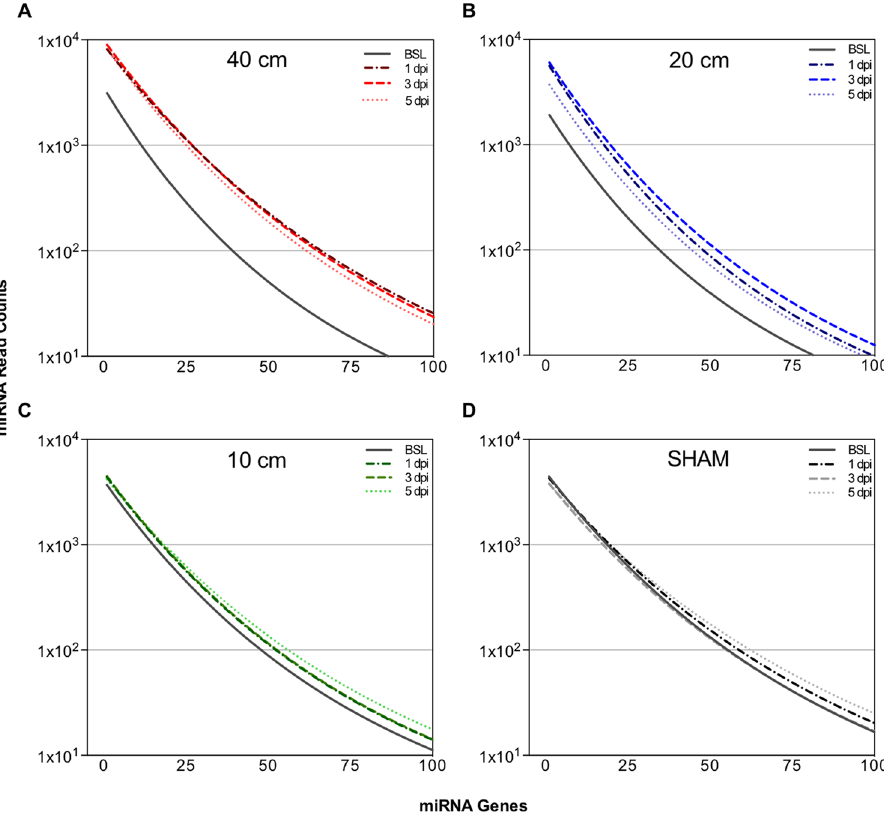
Figure 6. Effect of Injury Severity on Global miRNA Expression. Smoothed lines showing the trend in global miRNA expression at BSL (solid lines), and at 1, 3, and 5 dpi (dashed lines) in each of the ( A ) 40 cm, ( B ) 20 cm, ( C ) 10 cm, and ( D ) SHAM groups. Datapoints represent the smoothed read counts for the top 100 miRNA genes for n = 4 animals per group and time point (see Table